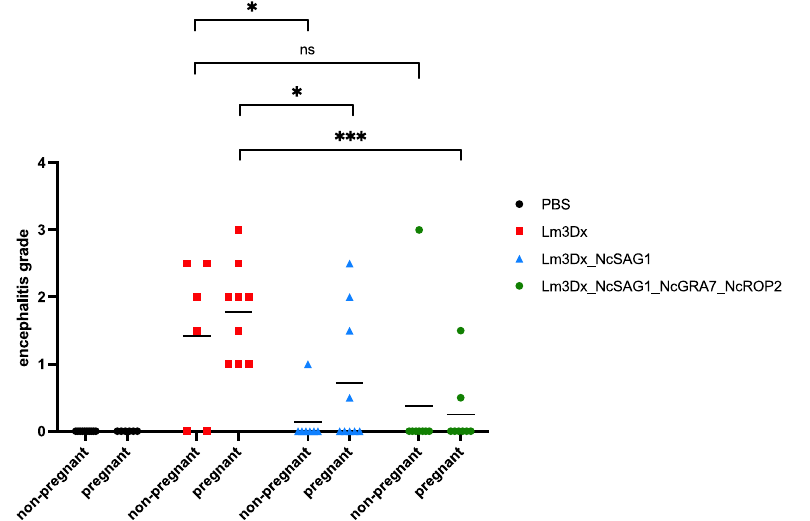
Figure 4. Brain samples were formalin-fixed, embedded in paraffin, cut in slices of 4 µm and stained with HE. N. caninum -associated lesions were assessed under the light microscope, and encephalitic grades were scored from 0–3. Grades were analyzed between groups by the non-parametric Kruskal–Wallis test. Afterwards, the encephalitic grades of non-pregnant mice vaccinated with Lm3Dx_NcSAG1 and Lm3Dx_NcSAG1_NcGRA7_NcROP2 were compared to non-pregnant mice that were immunized with the Lm3Dx (vaccination with empty vector and infected with N. caninum tachyzoites) using the Mann–Whitney U test (* p < 0.0373; ns = not significant). The same statistical analysis was performed comparing dams immunized with Lm3Dx_NcSAG1 and Lm3Dx_NcSAG1_NcGRA7_NcROP2 with dams vaccinated with the empty vector